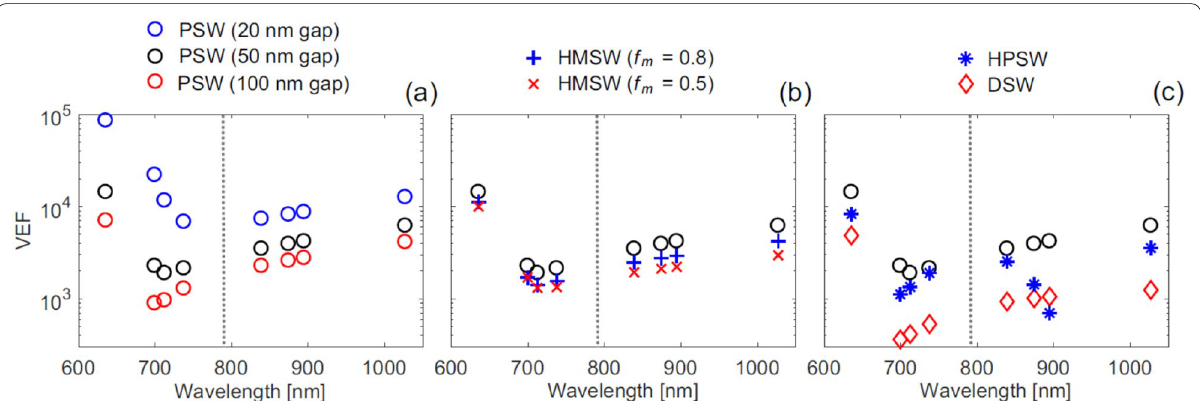
Fig. 5 Maximized volume enhancement factor (VEF) with the optimal WG length for the case of in-plane excitation and forward scattered signal collection (see Fig. 1), as a function of wavelength for the Ag plasmonic slot WG (PSW) with gap width g 50 nm, and other WGs obtained by a = varying the gap width g: Ag PSW with gap width g 100 and 20 nm, b varying the metal filling fraction f m : Ag-Si 3 N 4 HM slot WG (HMSW) with = f m 0.8 and 0.5, and c changing the WG type: Ag-Si 3 N 4 hybrid plasmonic slot WG (HPSW) and Si 3 N 4 dielectric slot WG (DSW). The results here are = based on comparing to a reference Gaussian beam focused using an objective lens with NA 0.75 that has a waist diameter D 0 1.28 μm and = ≈ depth of focus b 17.4 μm. Note that changing the Gaussian beam parameters will simply scale the VEF. Each marker indicates a specific Stokes ≈ or anti-Stokes wavelength corresponding to one of the Raman modes. The vertical dotted line indicates the pump wavelength at λ 0 785 nm. = (Reprinted with permission from Ref.